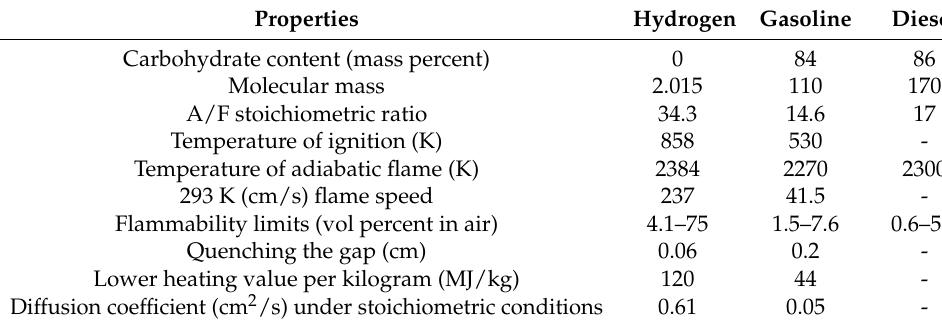
Table 1. Hydrogen, gasoline, and diesel have different characteristics.